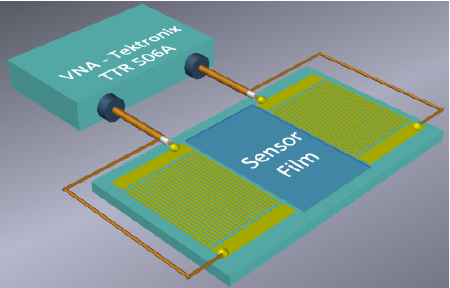
Figure 8. Schematic view of the Rayleigh SAW delay line with sorbent film between transducers. The frequency dependencies of the S 12 parameter for various numbers of monolayers of the LB SA film were measured using a vector network analyzer TTR 506A (Figure 9). It is seen that for the numbers of layers changing from 0 to 13, the insertion loss S 12 is de- creased from − 32dB to − 31.2 dB. On the contrary, for the number of layers changing from 13 to 25, the insertion loss S 12 is increased from − 31.2 dB to − 33.1 dB (Figure 9b). The min- imum insertion losses are measured for 0 to 25 monolayers.